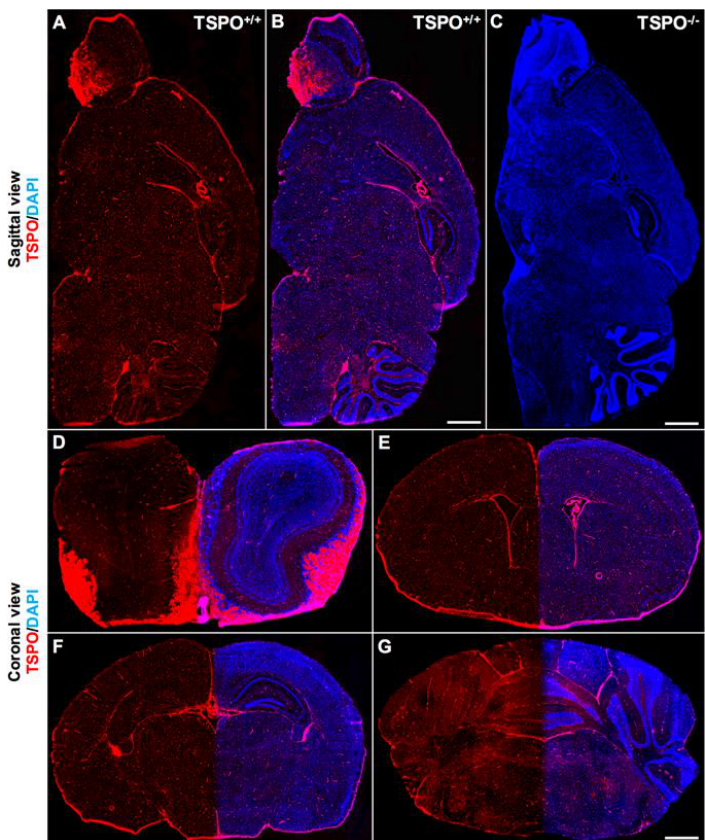
Figure 1. Global immunofluorescence overview of TSPO (translocator protein 18 kDa) expression across major brain regions. ( A ) Sagittal section from a wildtype mouse (TSPO +/+ ) demonstrates widespread TSPO expression (red) across all brain regions using a specific antibody against TSPO (anti-PBR, ab109497). ( B ) Sagittal section from a wildtype mouse with TSPO expression in red and 4’,6-diamidino-2-phenylindole (DAPI) in blue highlighting structural features. Strong TSPO immunoreactivity is present in the olfactory bulb, the choroid plexus and the ependyma of the ventricular system, and cerebellum. ( C ) Sagittal section from a TSPO knockout mouse (TSPO −/− ) confirming the absence of TSPO expression (DAPI in blue). ( D ) Coronal view of the olfactory bulb demonstrates strong TSPO expression in the olfactory nerve layers and glomeruli, and concentrated expression in the subependymal zone. ( E ) TSPO expression is present in the subventricular zone and the ependymal cells of the ventricles and choroid plexus. ( F ) Coronal view of the hippocampal region with discernible TSPO expression observed in the dentate gyrus. ( G ) Cerebellar/brainstem TSPO expression is strongly present in the molecular layer of the cerebellar cortex and fiber tracts of the brainstem. Scale bars = 500 µm.